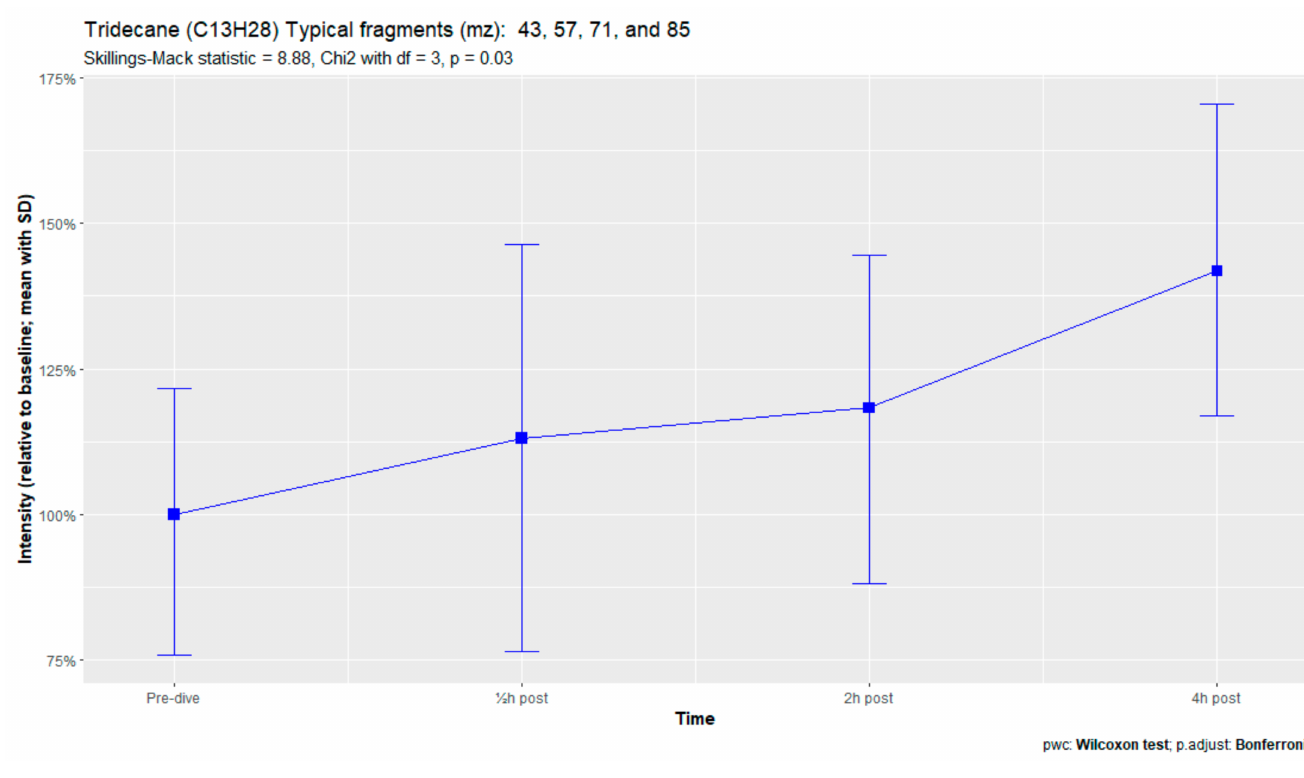
Figure A3. Tridecane.